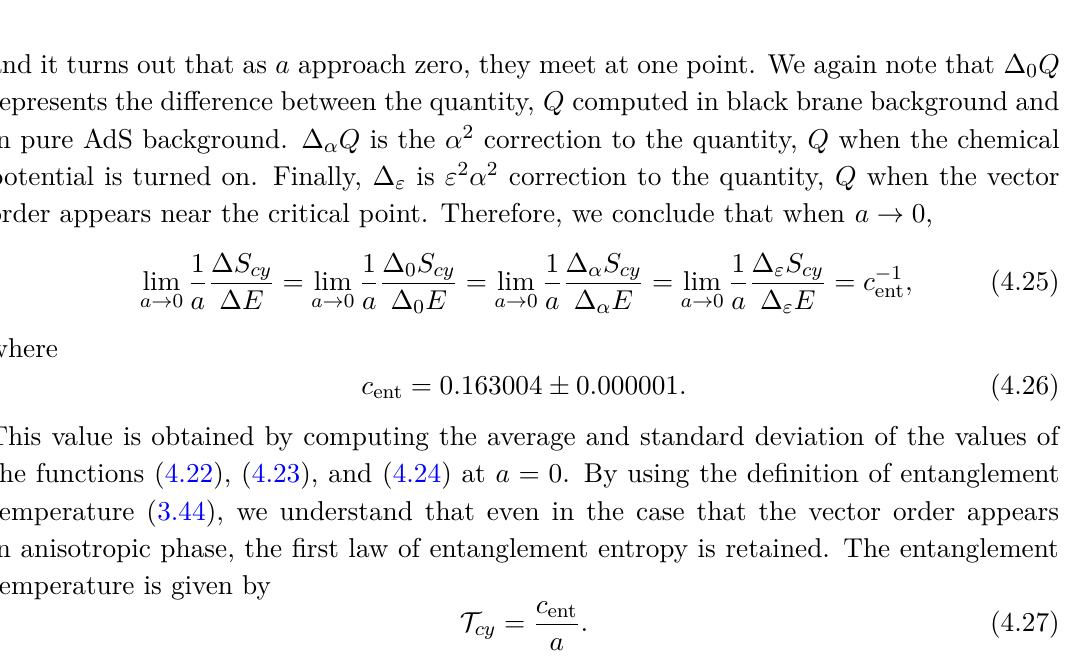
Figure 2 . γ ( α ) ( a ) = 7 . 8111218 a 3 + . . . , from a = 7 . 96204 × 10 − 5 to a = 0 . 403790 , 5000 data